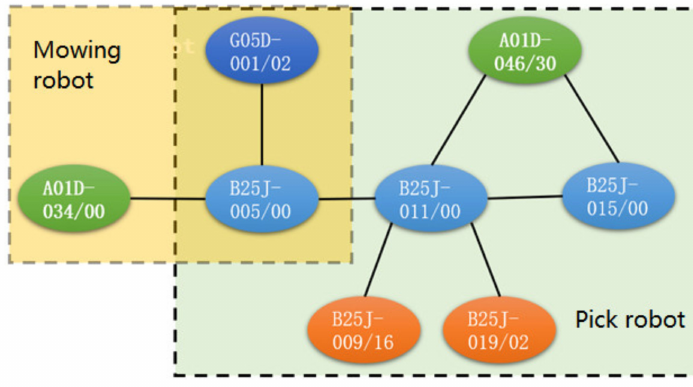
Figure 9. Key technology path recognition results based on IPCNet